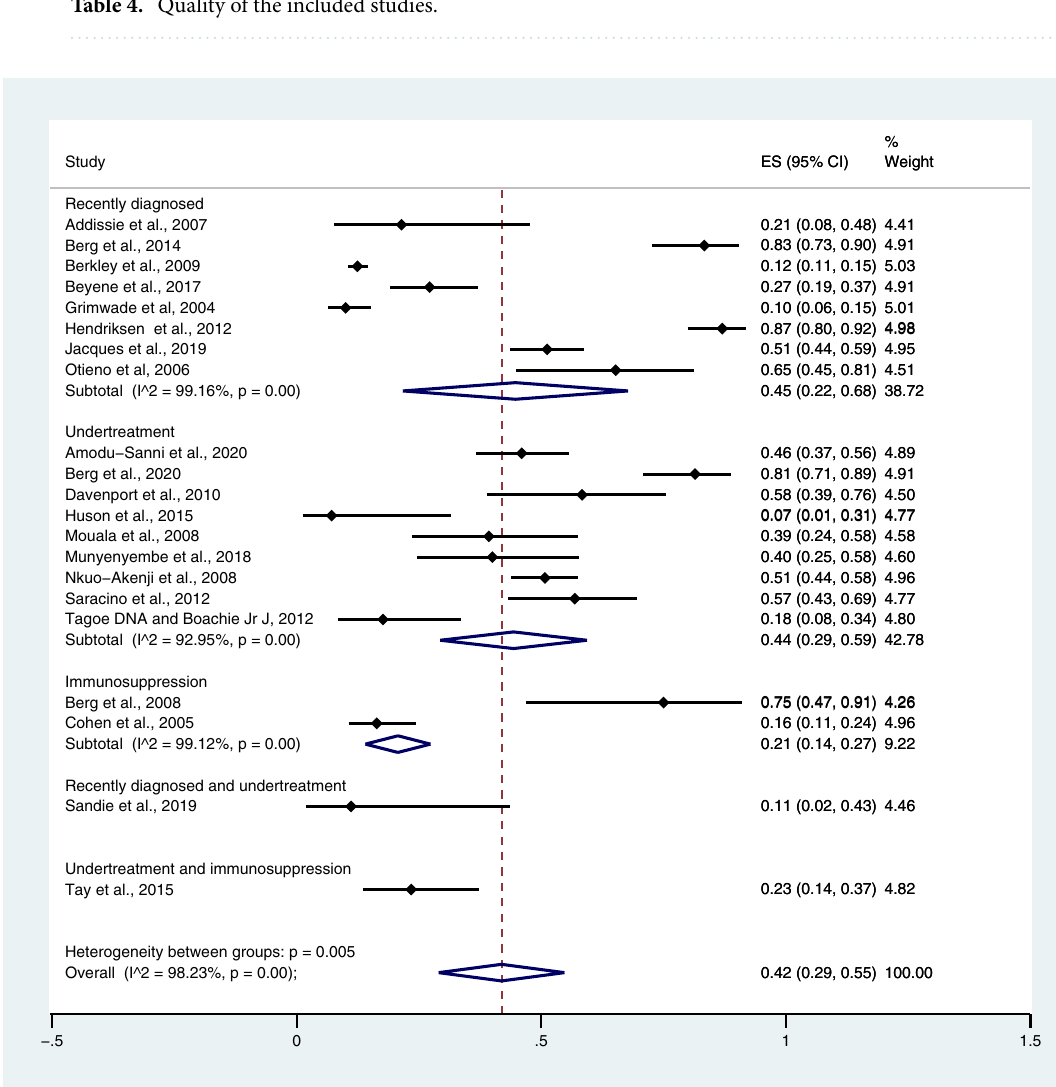
Table 4. Quality of the included studies.